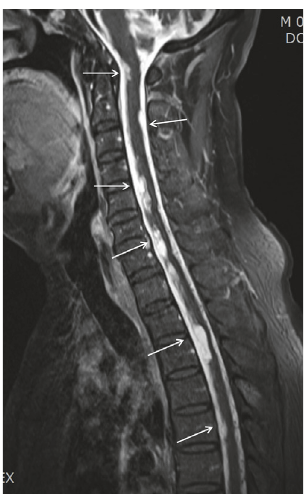
Figure 1: Magnetic resonance imaging (MRI) findings of communicating hydrocephalus and leptomeningeal enhancement in the basal cistern at the time of initial manifestation of mental confusion